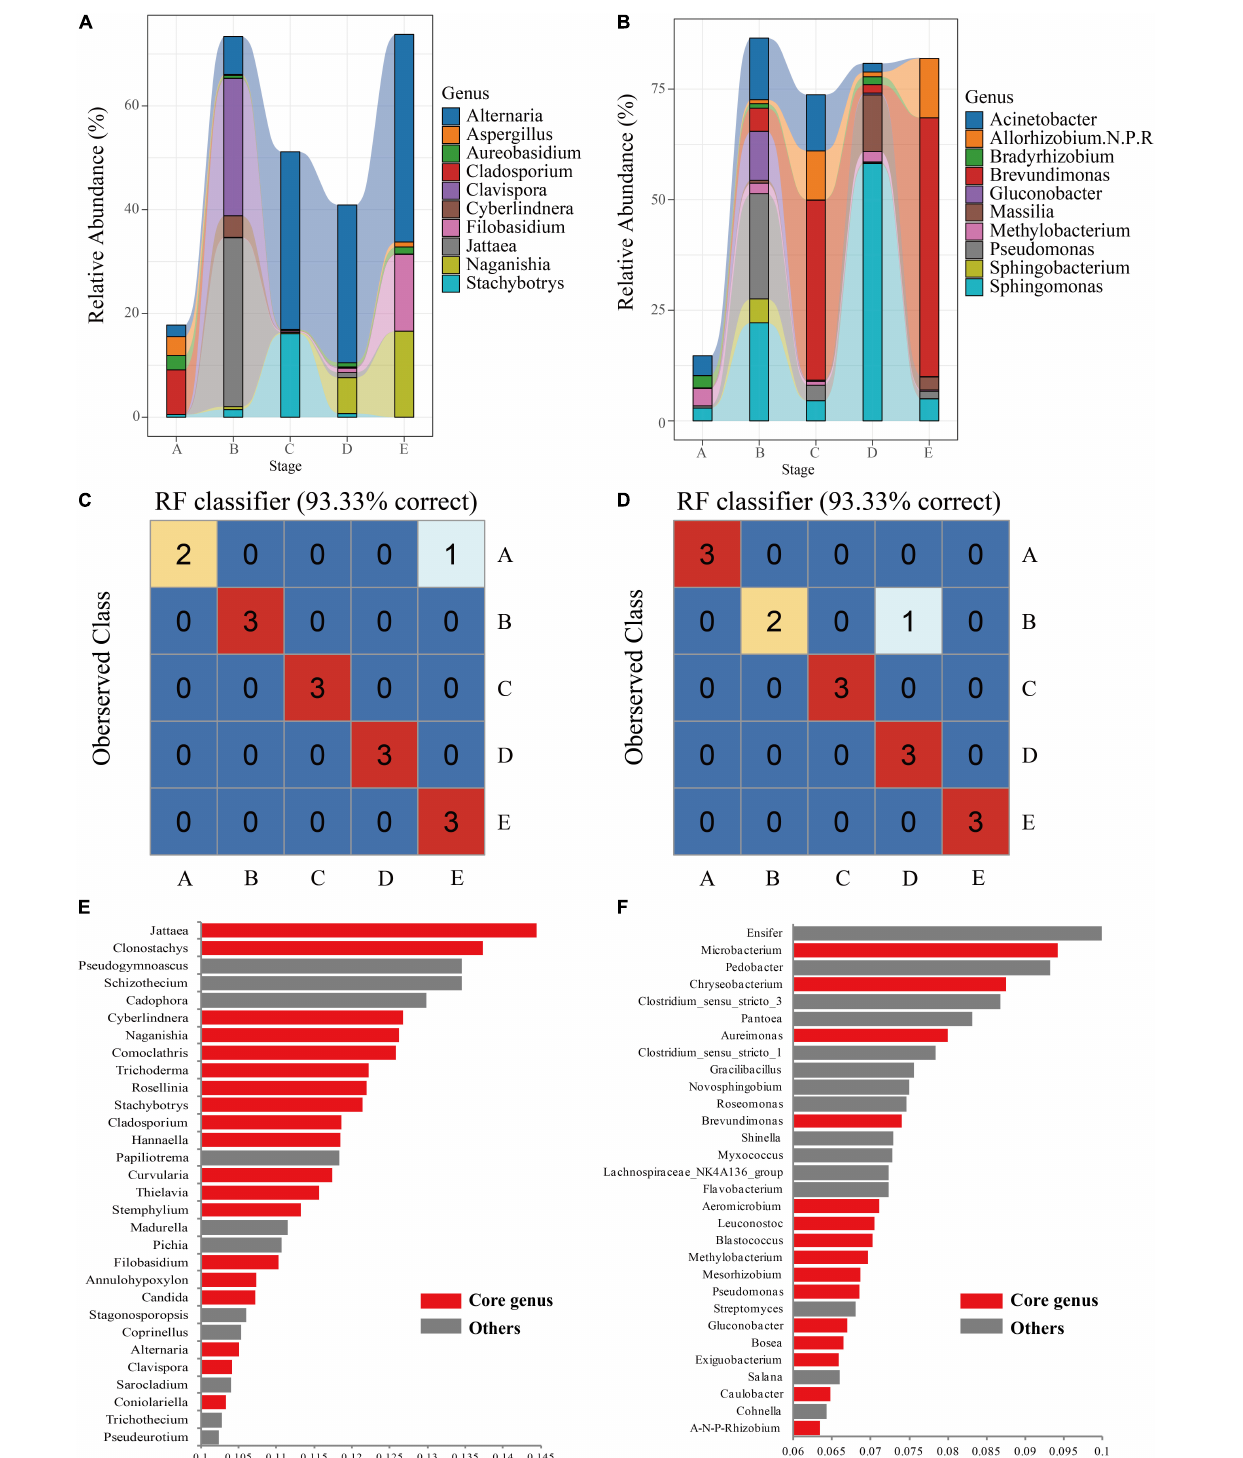
Frontiers in Microbiology |